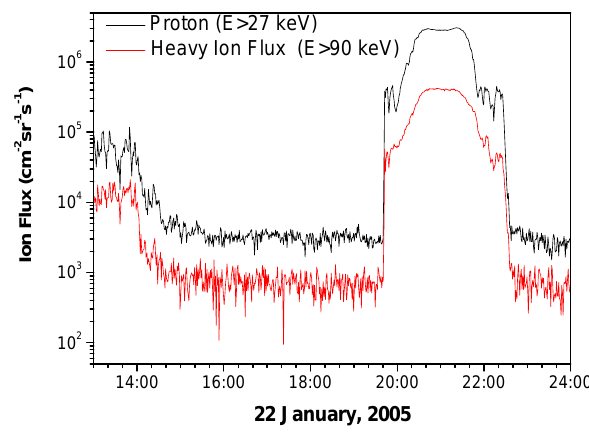
Fig. 4. Integral ion fluxes averaged over 4 π by the RAPID/Cluster instrument within the magnetosphere, where the black curve repre- sents proton fluxes ( E> 27keV) and the red curve heavy ion fluxes ( E>